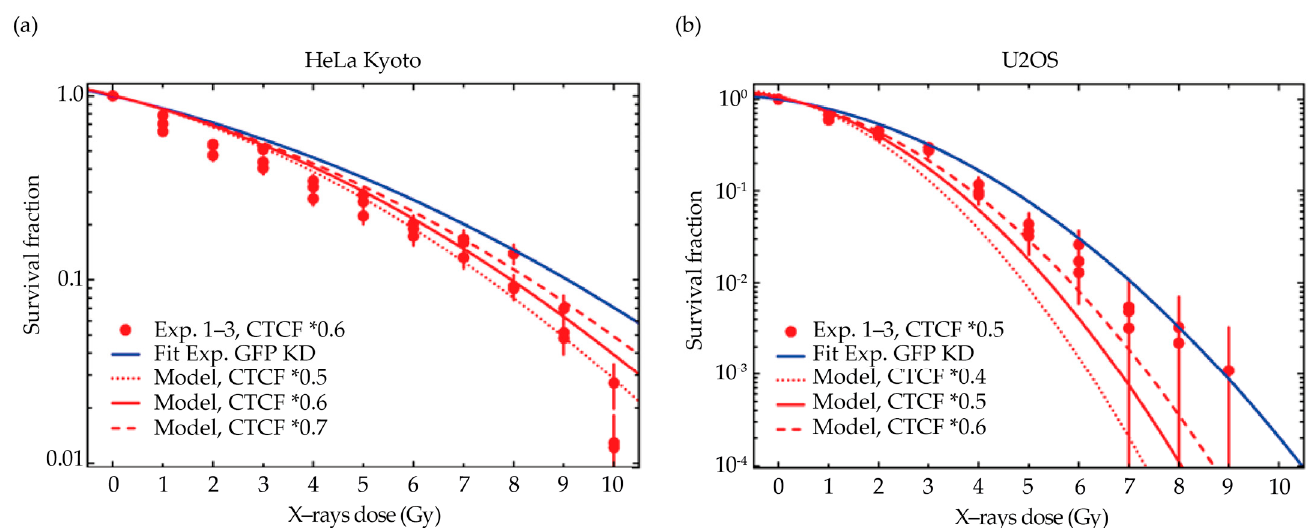
Figure 4. GLOBLE predictions of clonogenic survival upon different levels of CTCF depletion in HeLa Kyoto ( a ) and U2OS ( b ) cells, in comparison to the experimental data. The LQ parameters for the reference conditions were determined based on the GFP KD control survival (full blue curve, fitting weighted by 1 ). Full red lines indicate the model’s predictions for the experimentally determined CTCF depletion level, whose experimental data from three biological replicates is shown as dots for comparison (whiskers = error bars); the predictions for the other knockdown levels are shown as dashed lines to indicate the expected impact of the knockdown efficiency. ( a ) GLOBLE predictions for HeLa Kyoto. ( b ) GLOBLE predictions for U2OS. The same predictions are plotted with equal y axis scaling in Figure S5c,d, for